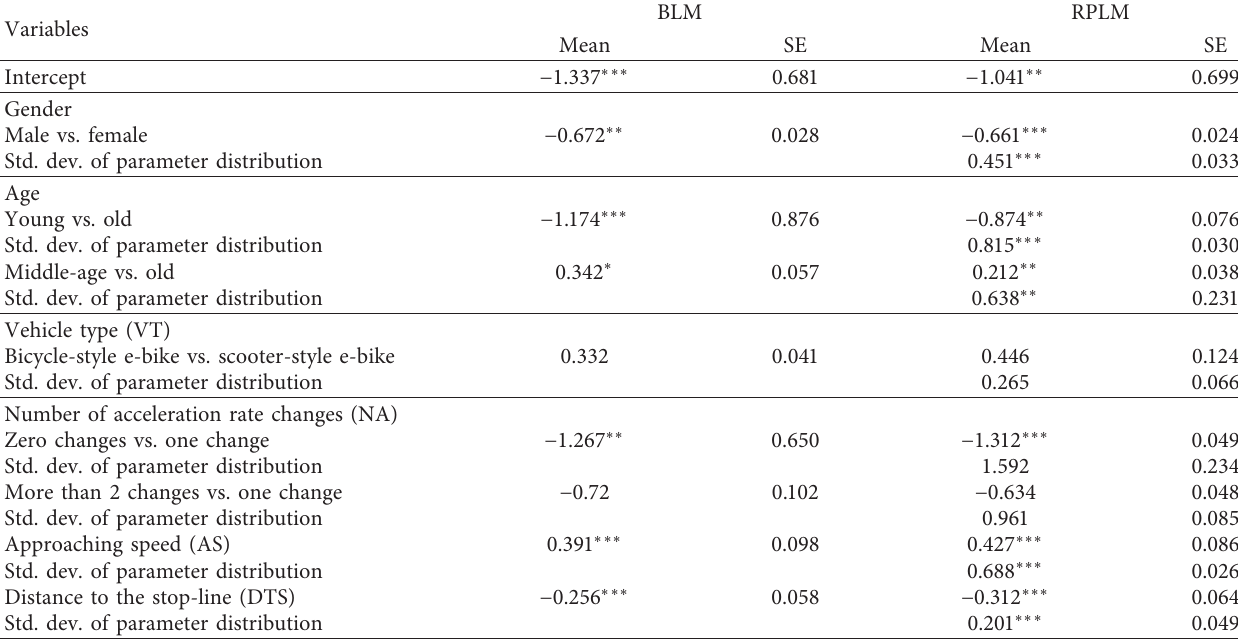
Table 4: Estimates of parameters in BLM and RPLM for e-bikers’ YLR behaviour.